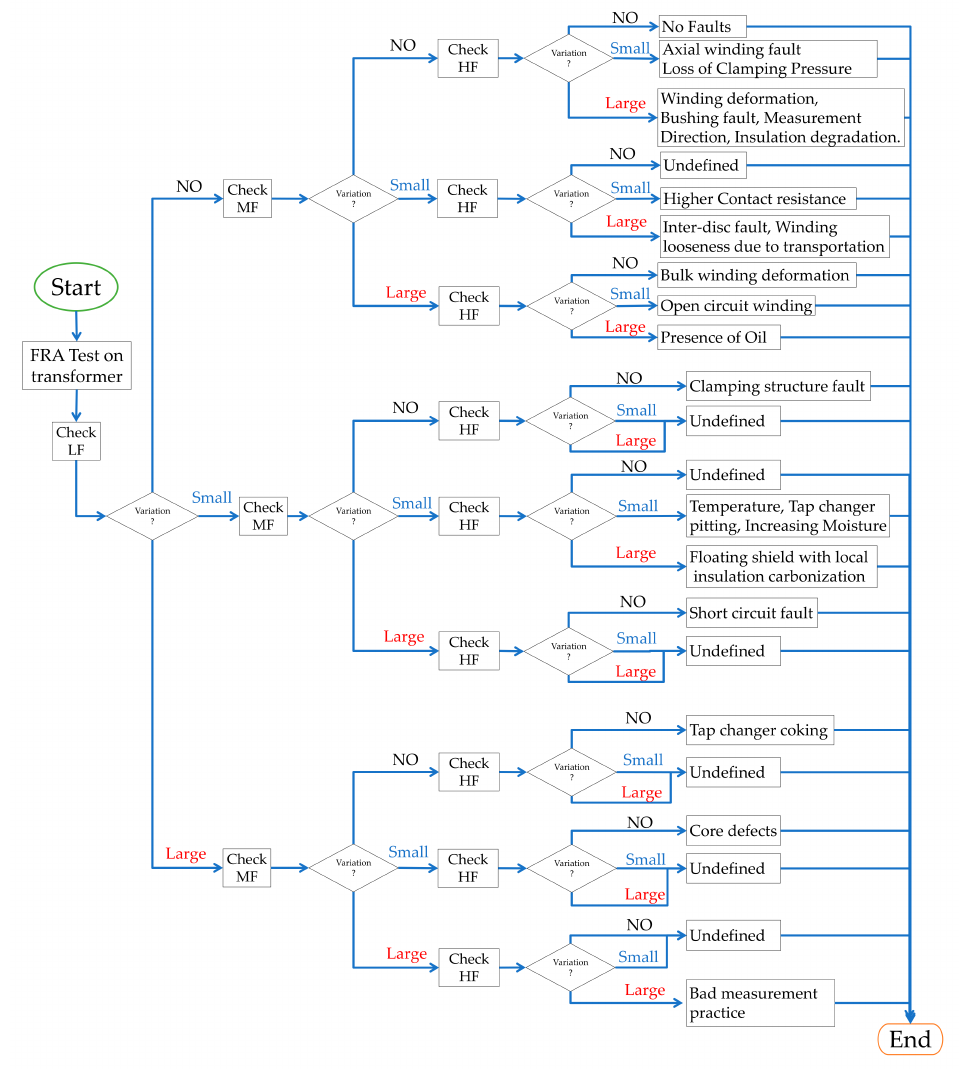
Figure 9. The proposed FRA interpretation